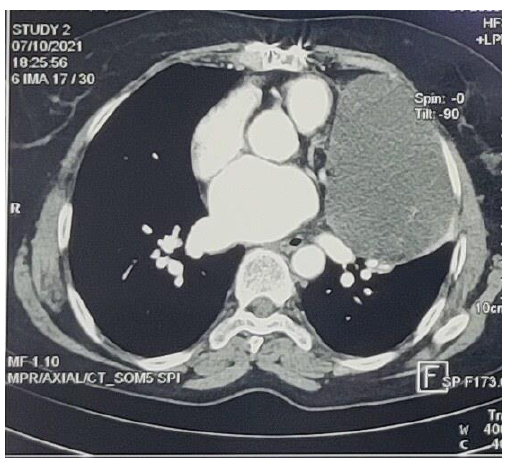
Figure 2. CT scan demonstrating large cystic lesion in anterior aspect of left lung.